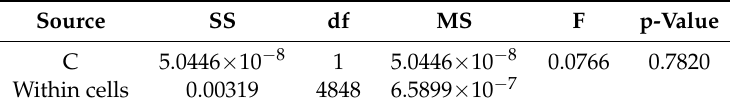
Table A4. One-way ANOVA table for factor C given B =